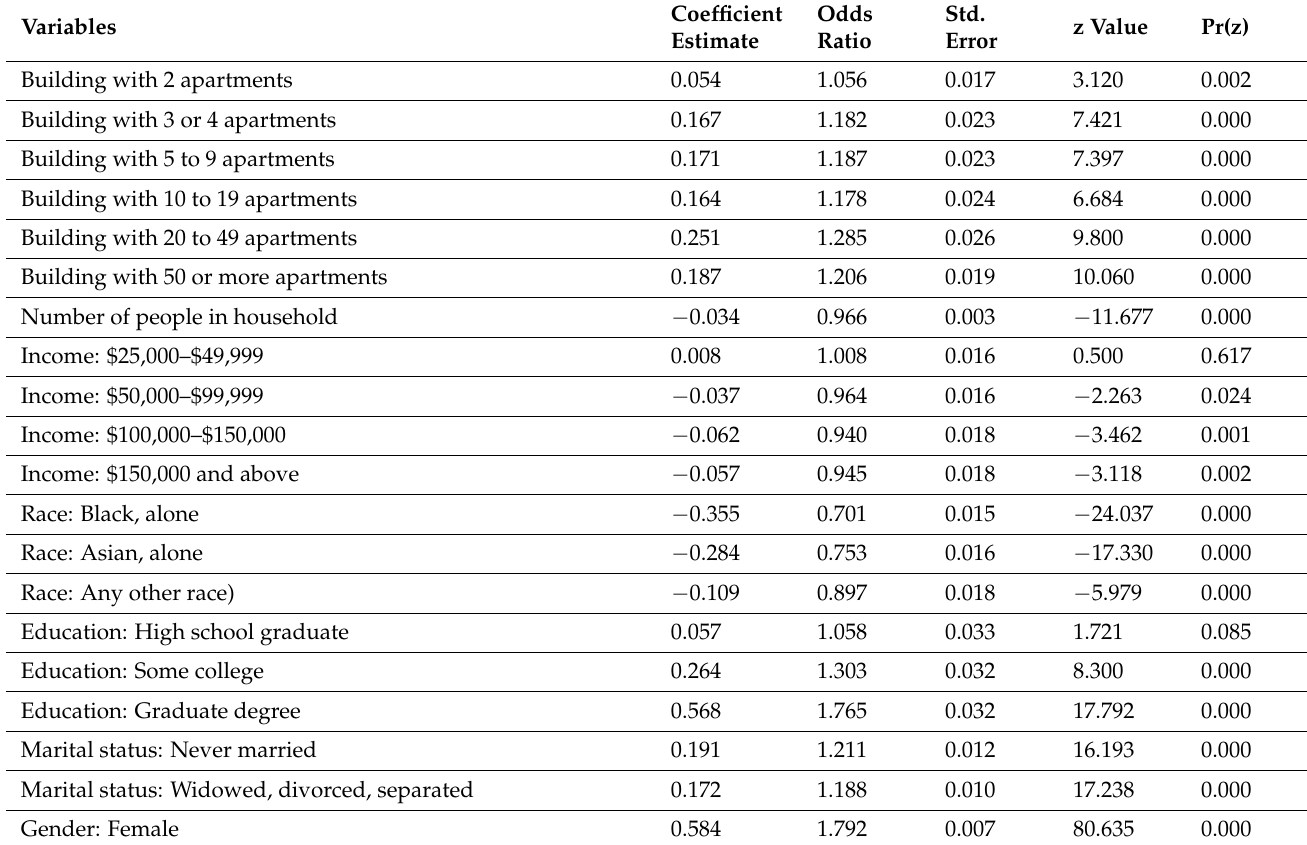
Table 6. Logistic regression—mental health with building type and number of people in the household as predictor variable.